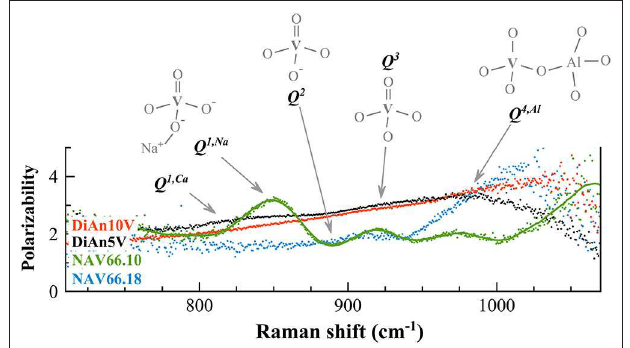
FIGURE 9 | The calculated polarization ratios of the different V-doped glasses (polarizability) allowed us to discriminate the different vibrations in the Raman frequency range between 750 and 1,050 cm − 1 exclusively related to vanadium. To each contribution is associated the probable V 5 + species responsible for the vibration. Details of the V species are reported in the